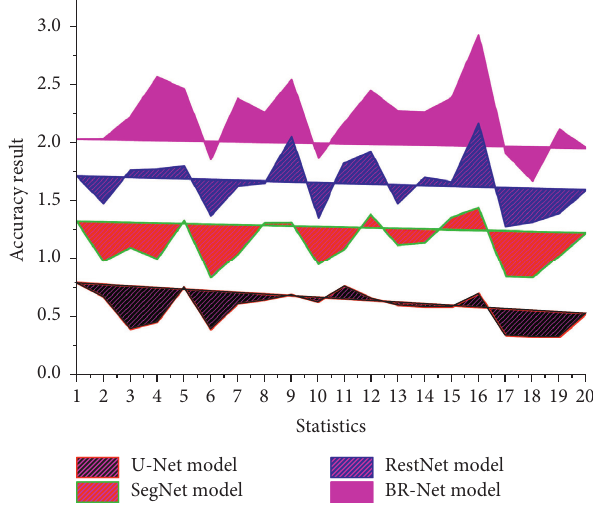
Figure 5: Accuracy of region extraction results.